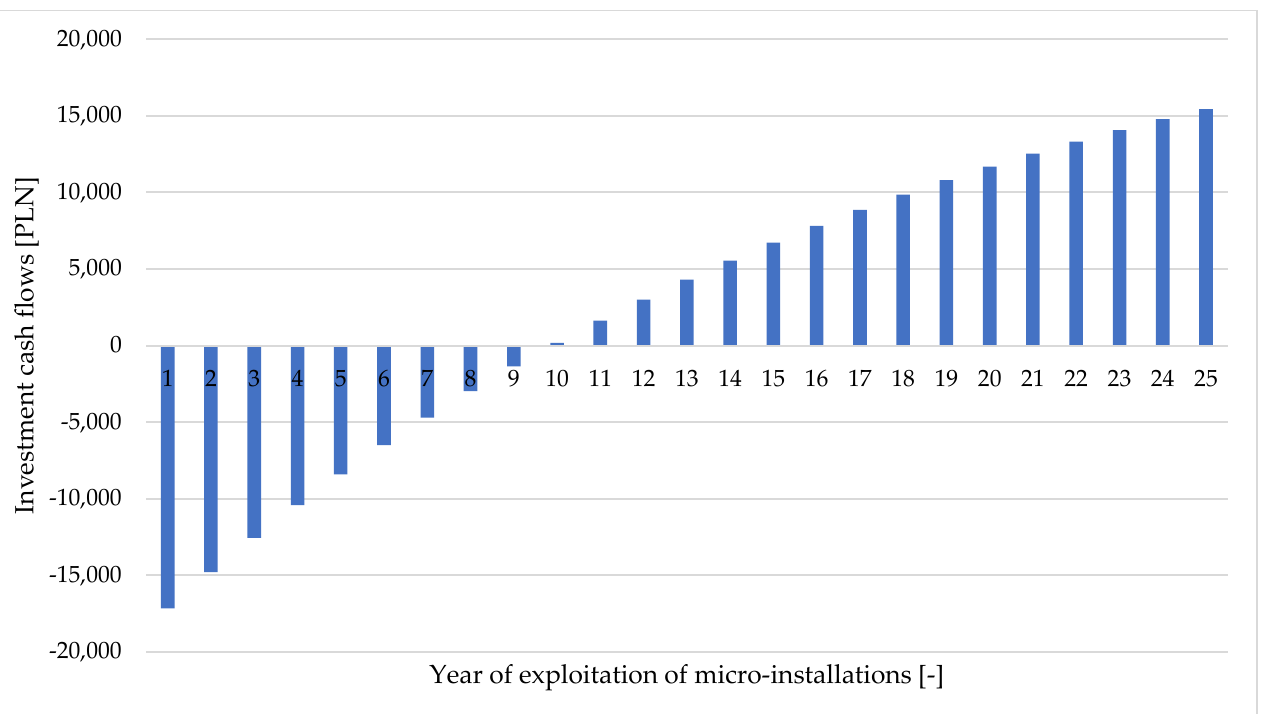
Figure 10. Graph showing the investment cash flow as a function of time of operation for the net- billing system based on monthly prices and a 50% self-consumption level.